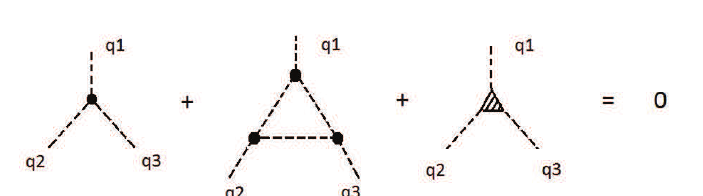
Figure 1. Diagram representation of the compensation equation in the first approximation. Dotted lines correspond to gravitons, a black spot represents the interaction by Equation (2), and the striped triangle represents the contribution of the Standard Model